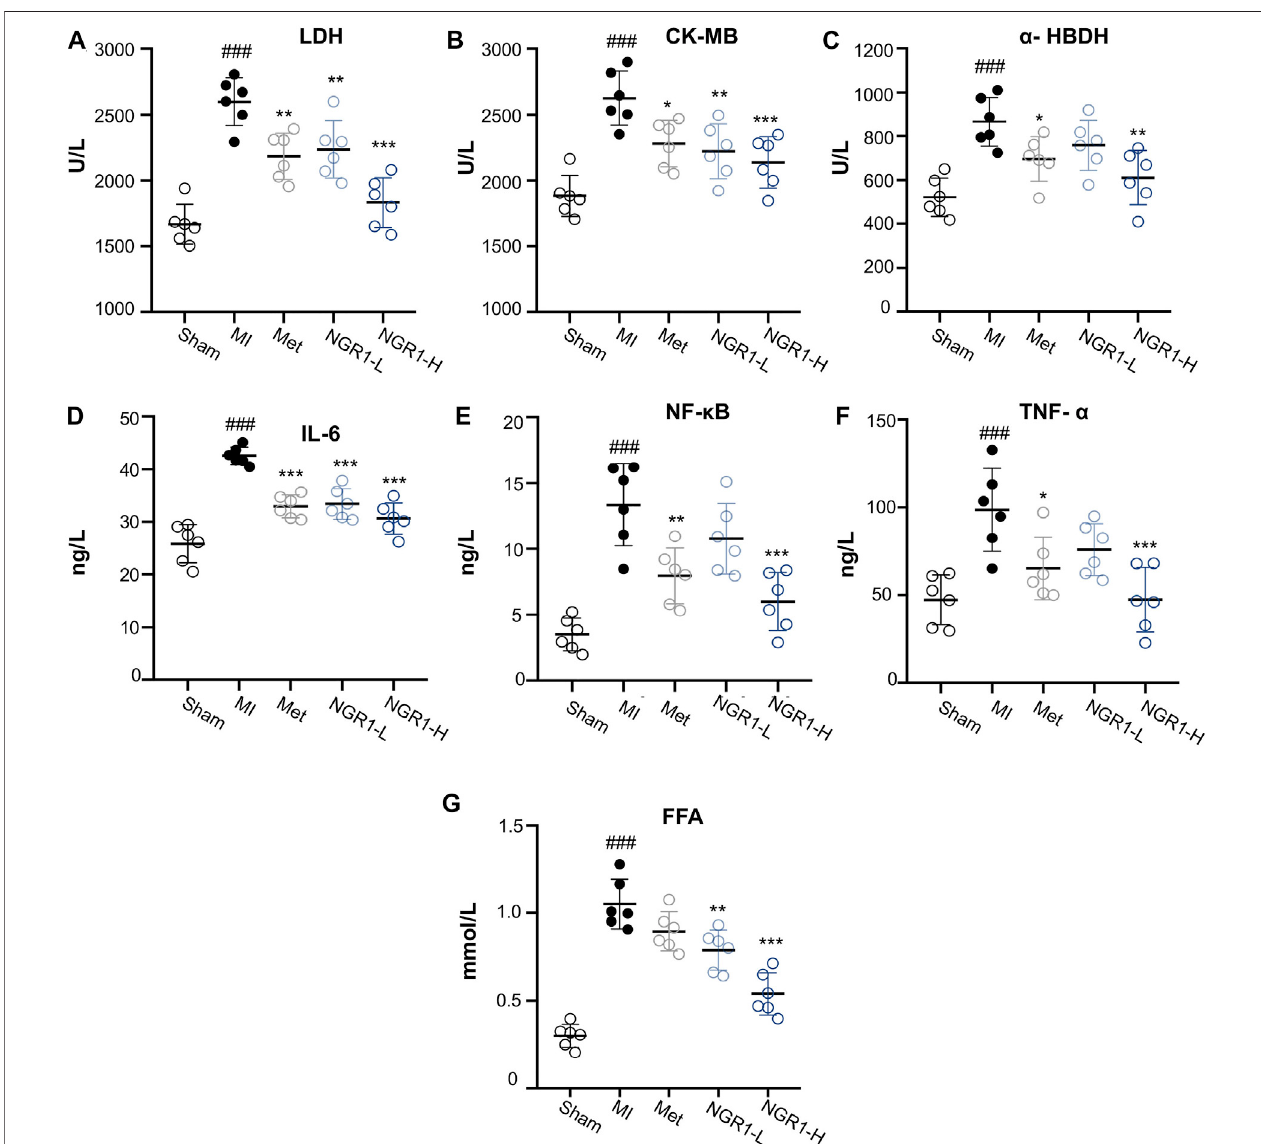
FIGURE 3 | Effects of NGR1 on serum biochemical indicators in LADCA-ligated rats. (A) LDH; (B) CK-MB; (C) α -HBDH; (D) IL-6; (E) NF- κ B; (F) TNF- α ; and (G) FFA.Valuesexpressedasthemean±SD.* p < 0.05,** p < 0.01,and*** p < 0.001vs.theMIgroup; # p < 0.05, ## p < 0.01,and #### p < 0.001vs.theshamgroup( n =6for sham, MI, Met, NGR1-L, and NGR1-H